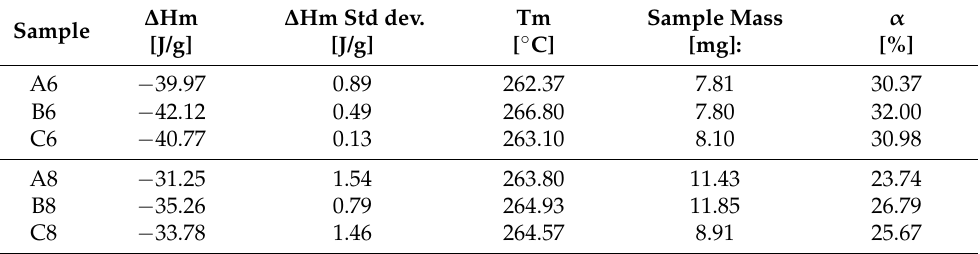
Table 5. The enthalpy of melting ( ∆ H m ) of PA66 composite filled with 30 wt% glass fiber; melting temperature (T m ) of the composite; sample mass and calculated crystallinity ( α ) of 6 mm (A6. B6. C6) and 8.4 mm (A8. B8. C8) thick molded